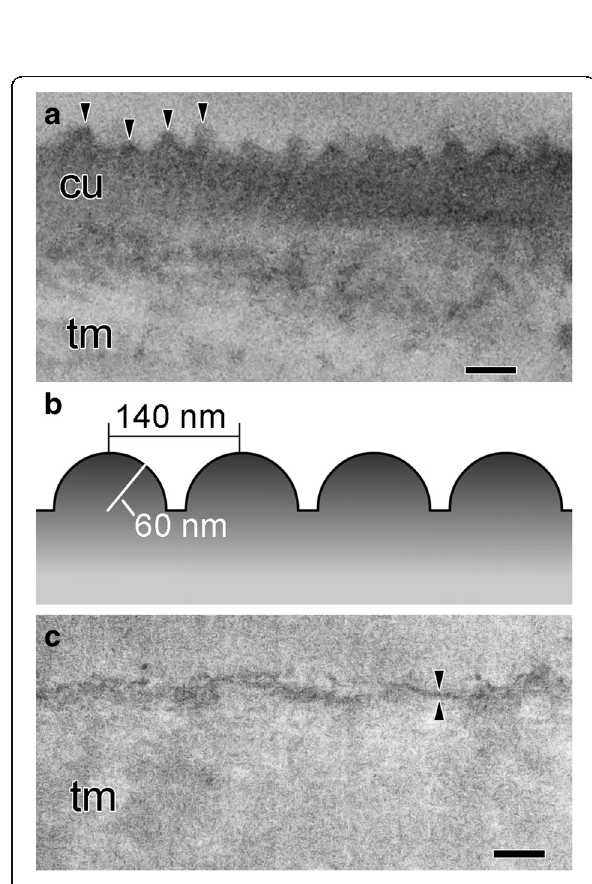
Fig. 4 Fine surface structure of Thetys vagina tunic ( a TEM; b model for the simulation of light reflectance) and Rhopalaea sp. tunic ( c TEM). Arrowheads in a indicate cuticular protuberances, and facing arrowheads in c indicate the cuticular layer. cu, cuticular layer; tm, tunic matrix. Scale bars in a and c indicate 0.2 μ